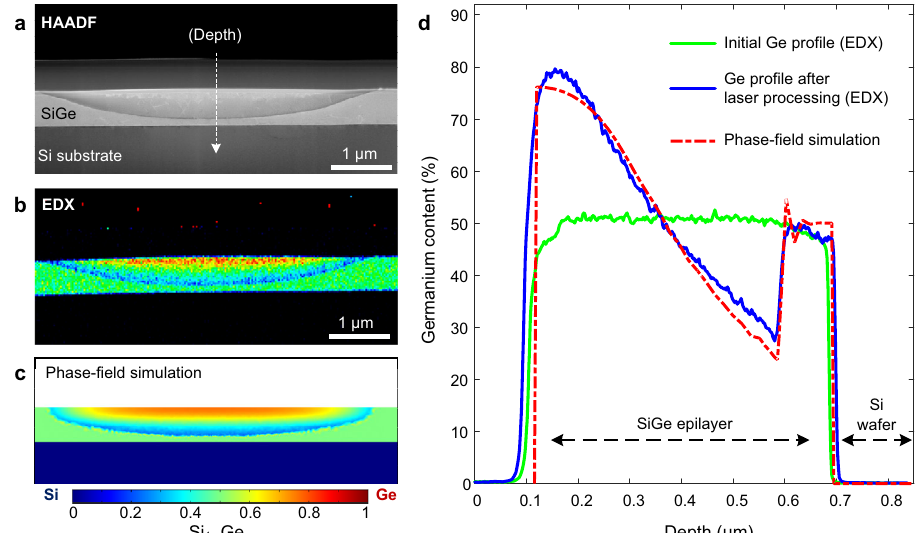
Fig. 4 Elemental analysis of an in-plane longitudinal SiGe heterostructure laser-written at a scan speed of 200 mm s − 1 . a High-angle annular dark- fi eld image (HAADF) showing the material contrast at the cross-section of the laser-processed region. b Energy-dispersive X-ray spectroscopy (EDX) and c phase- fi eld simulation results showing spatial redistribution of the alloy composition at the cross-section for 2D comparison. The color scale applies to both fi gures in b , c . d Quantitative comparison between the experimental (blue solid line) and simulated (red dashed line) Ge concentration along the depth pro fi le across the cross-section, as marked by a white arrow in a . The experimental error margin in the EDX data is 5%.